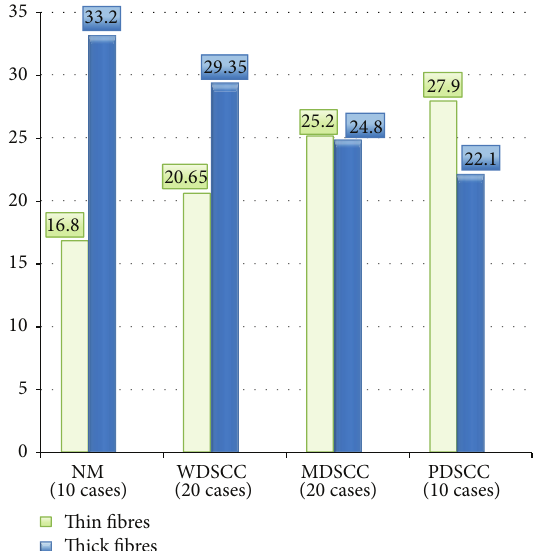
Figure 4: Thin and thick fibres arrangement in NM, WDSCC, MDSCC, and PDSCC (out of 50 fibres). ANOVA analysis: 𝐹 value: 124.31; 𝑃 value: 0.0000; interpretation: highly significant.